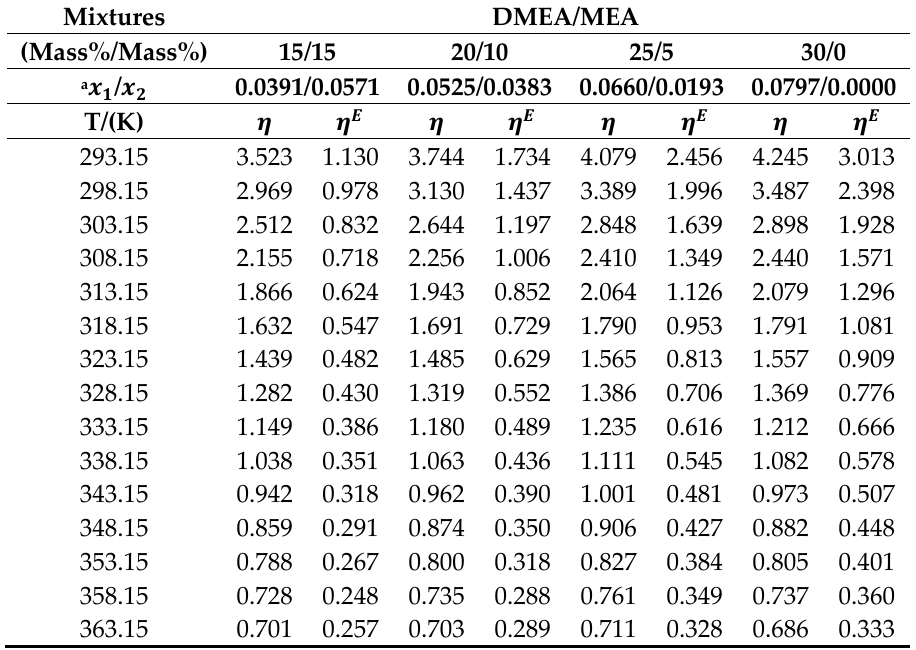
Table 12. Viscosities 𝜂 (mPa · s) and viscosity deviation 𝜂 𝐸 (mPa · s) of DMEA (1) + MEA (2) + H 2 O (3) mixtures.